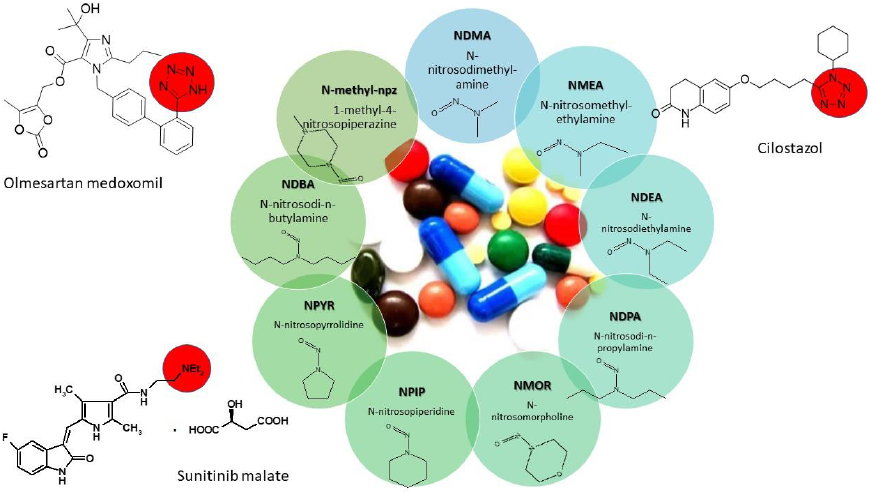
Figure 2. Structures of the APIs and nitrosamines presented in this study. Red circles—types of nitrosamine-related substructures present in APIs.